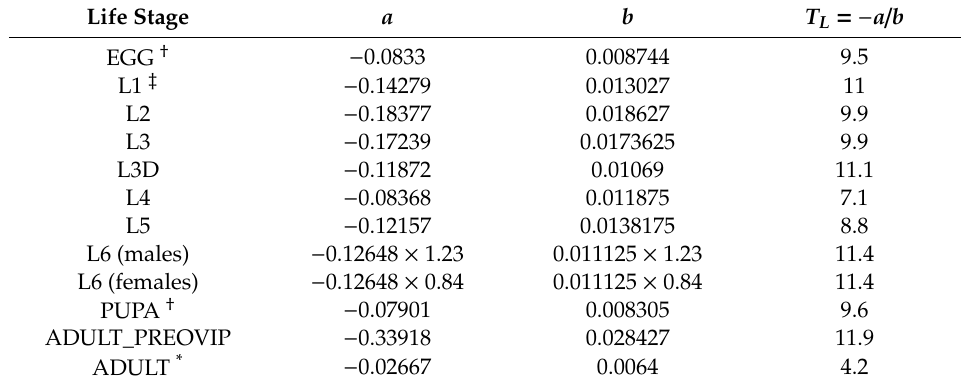
Table 1. Parameters of the development equation for all life stages of the OBL, Choristoneura